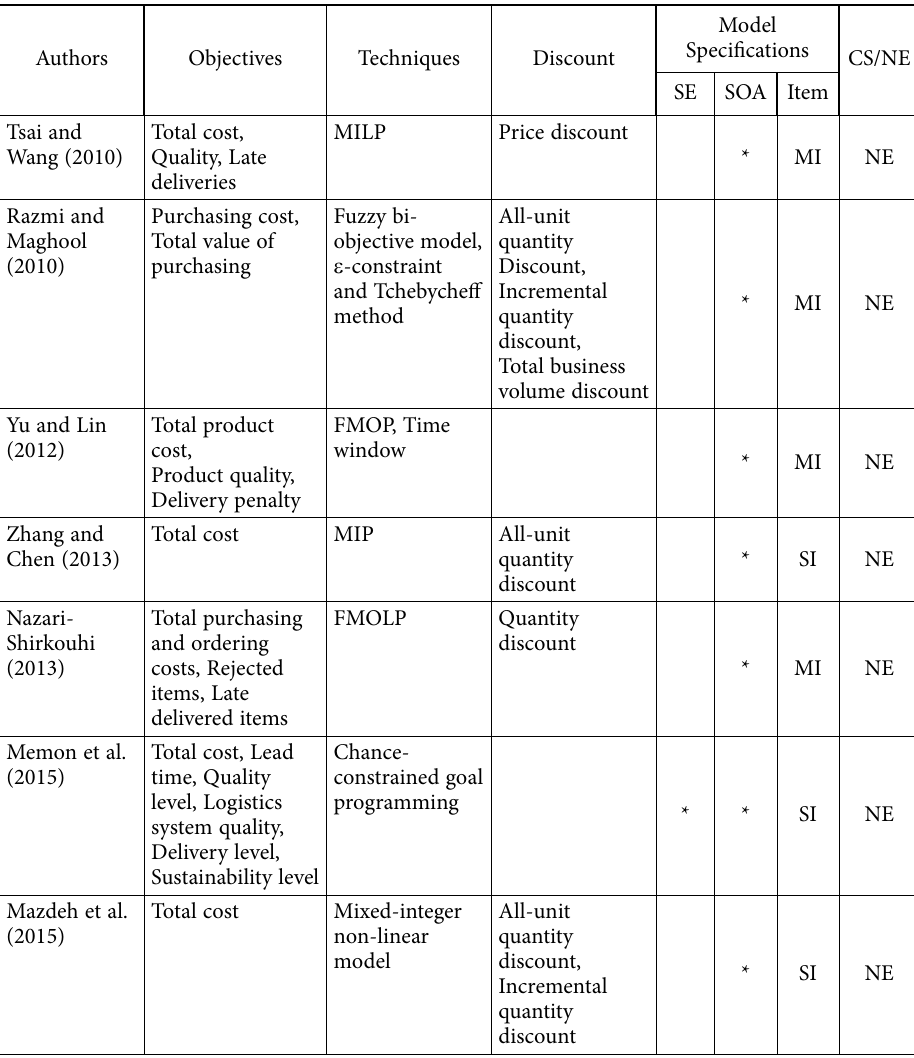
Table 1. Relevant literature and contributions on